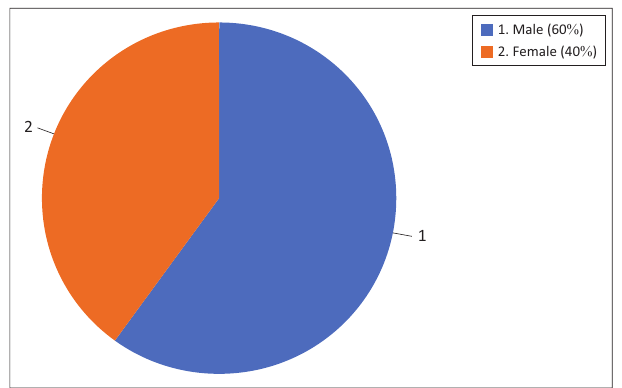
FIGURE 2: Gender distribution of study participants.